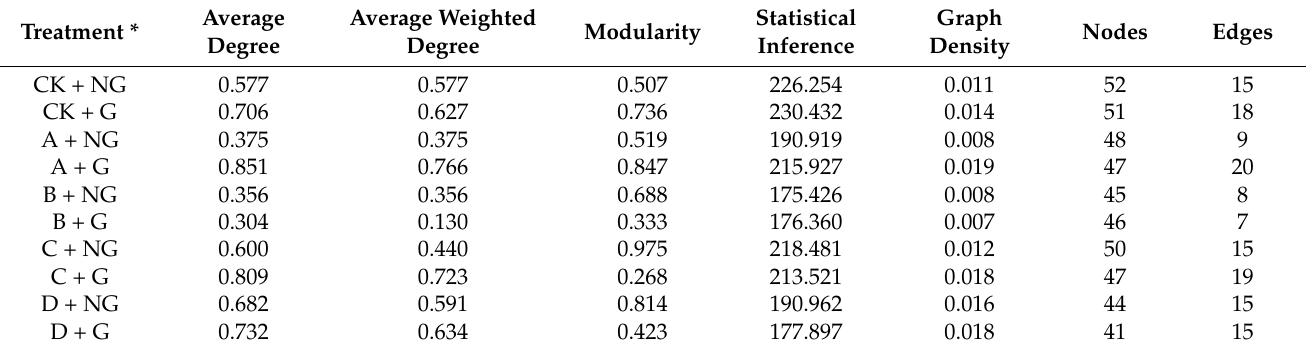
Table 1. Results of network co-occurrence analysis of plant communities under different treatments.